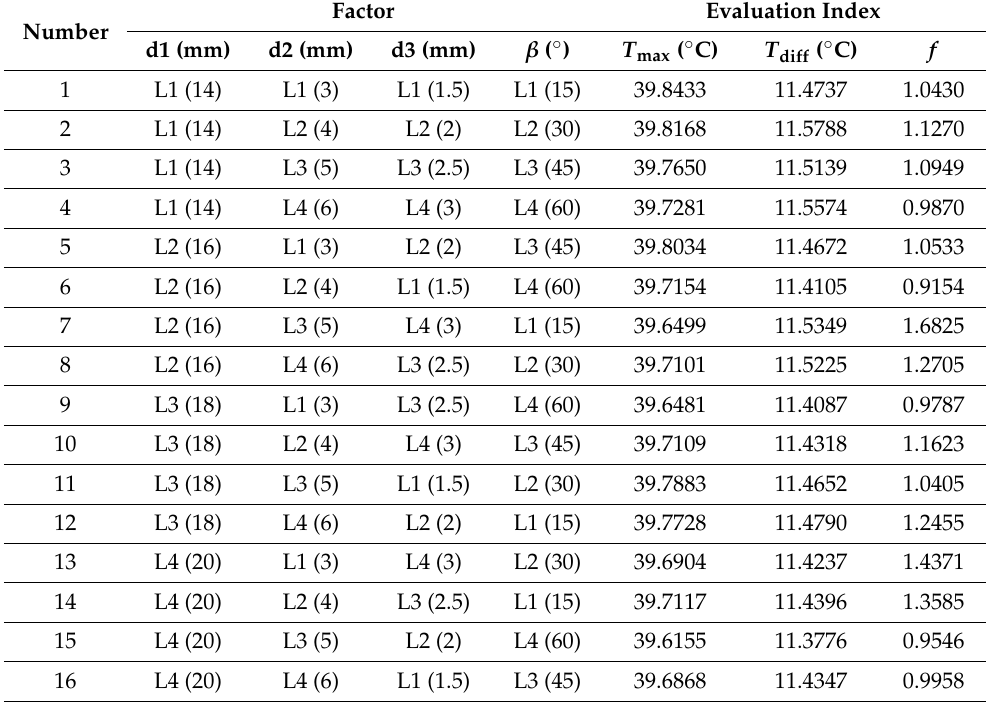
Table 4. Orthogonal test and simulation